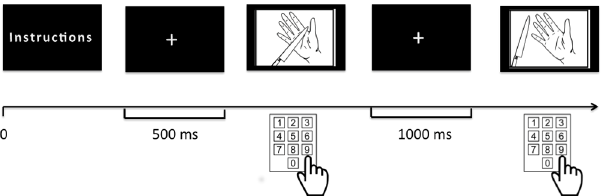
Fig 1. Schematic representation of the paradigm: the description of the task for each of the four blocks (Self, Other-Most-Loved-Familiar, Other-Most-Hated-Familiar and Other-Stranger) was presented and a fixation cross was displayed for 500 ms in the instruction part. An image of a painful or non-painful stimulus was presented until the participant had rated the imagined level of pain from 0 to 9 using a keyboard. After an interstimulus interval of 1000 ms, a new stimulus was displayed on the screen.